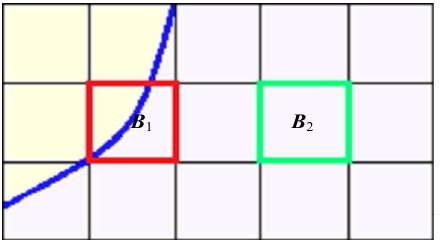
Figure 1. Comparison of the imperfect and perfect block.